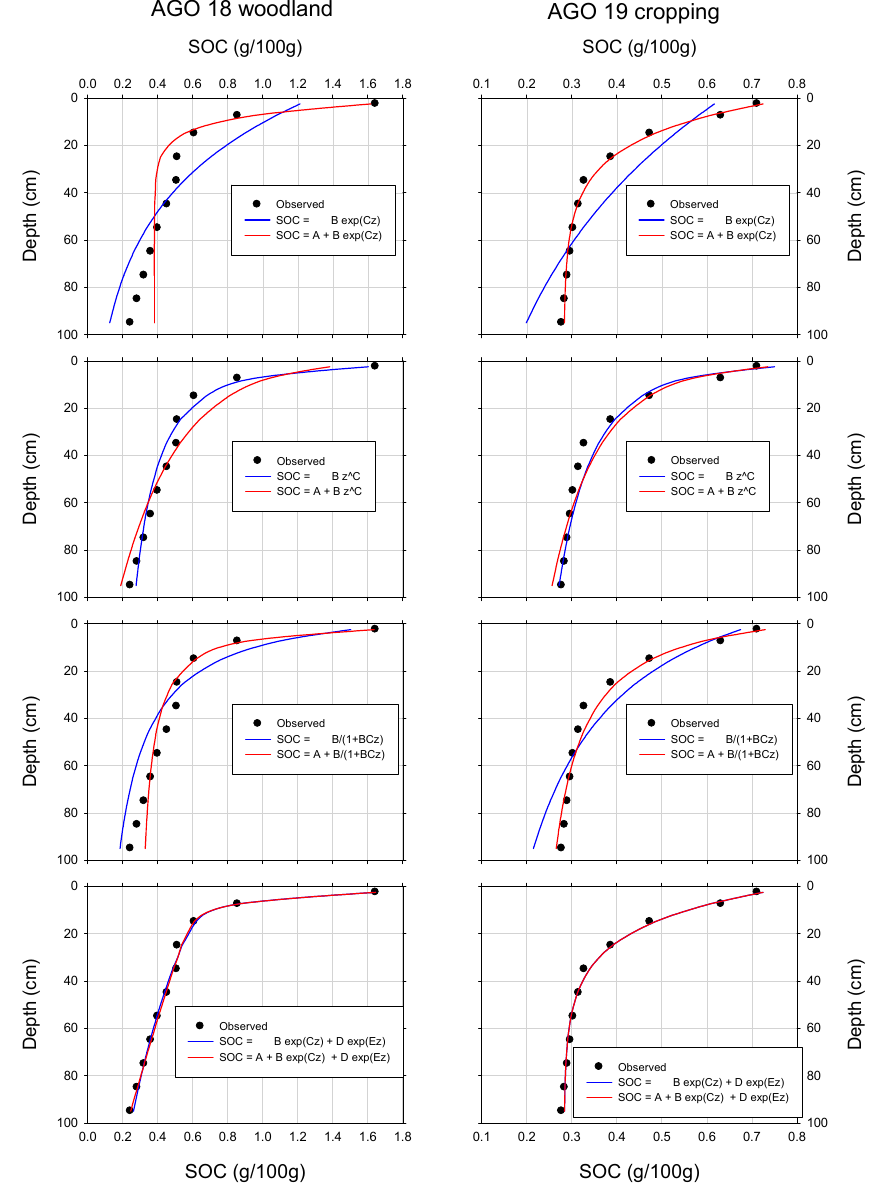
Figure 4. Demonstration of how the different mathematical functions (see Table 1) fit the measured data of SOC with depth for a paired site on Grey Vertosols on the Darling Riverine Plain in north Western NSW (Australian Greenhouse Office (AGO) sites 18 and 19).